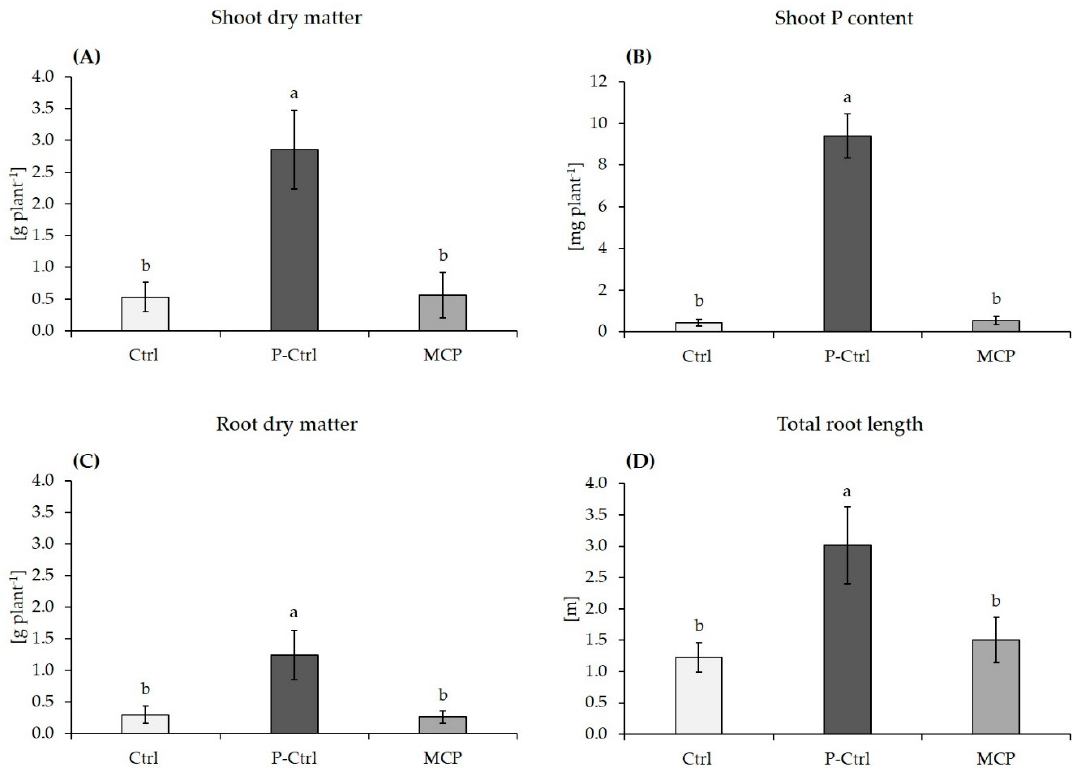
Figure 3. Shoot biomass ( A ), P content in shoot tissue ( B ), root dry matter ( C ) and total root length D )of maize plants (cv. Jessy) grown for 37 days on a calcareous Loess subsoil (pH 7.6) supplied with Rock-P (Ctrl, MCP treatment) or with soluble Ca(H 2 PO 4 ) 2 as positive control (P-Ctrl). All plants received DMPP-stabilized ammonium (80 mg N kg soil − 1 ) and calcium nitrate (20 mg N kg soil − 1 ) as nitrogen sources. Data represent means and SE of ten replicates. A One-way ANOVA with Tukey test was performed for data comparison. Different letters indicate significant differences between treatments ( p < 0.05).